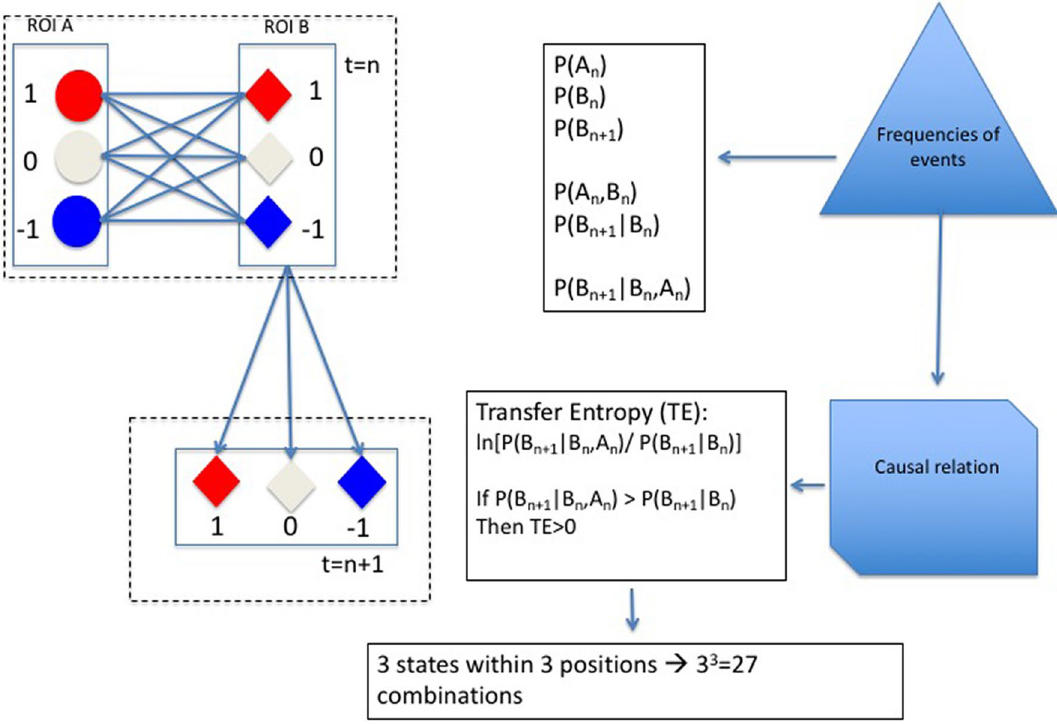
Figure 2. Characterization of dyadic interactions. Given the state value of two ROIs ( A , B ) at the time step (n) and the state of one of them ( B ) at the following time step (n + 1), a causal relation from ( A ) to ( B ) can be estimated by the Transfer Entropy (TE) through the calculation of: P(A n ), marginal frequency of A in a particular state (1, − 1 or 0) at the time step n; P(B n ) and P(B n+1 ), marginal frequencies of B in a given state (1, − 1 or 0) at the time step n and at the time step n + 1; P(A n ;B n ), joint frequency of A and B in a particular state at the time step n;